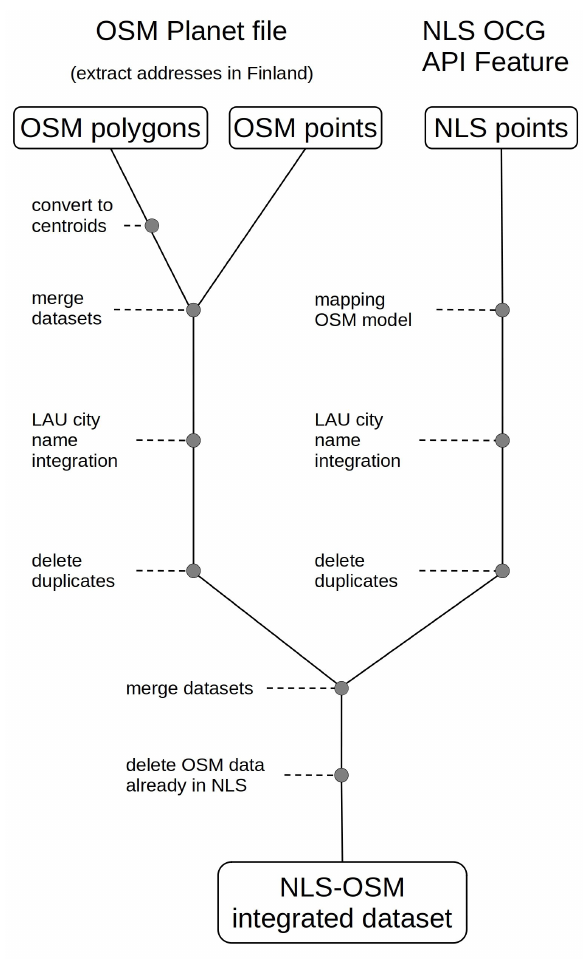
Figure 2: Graphical model of the processing performed to integrate the OSM and NLS address datasets in a single dataset.